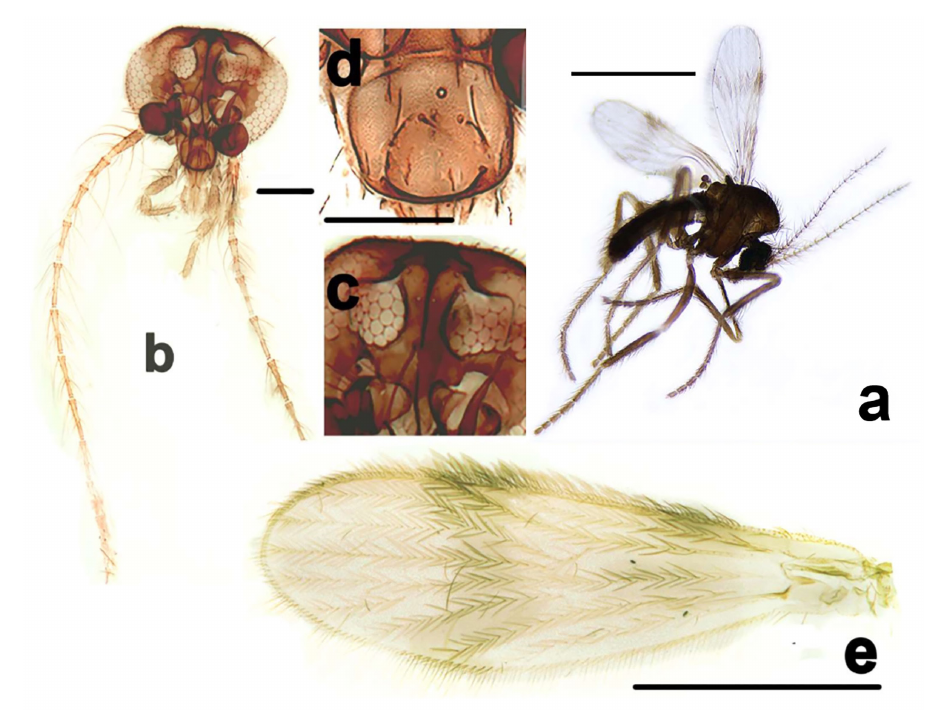
Fig. 7. Microphotography of Corethrella menini Feijó, Picelli, Ríos-Velásquez & Pessoa sp. nov. ♀, holotype (ILMD 0001 - 57). a . Habitus. b . Head. c . Head with coronal suture elongate. d . Clypeus.